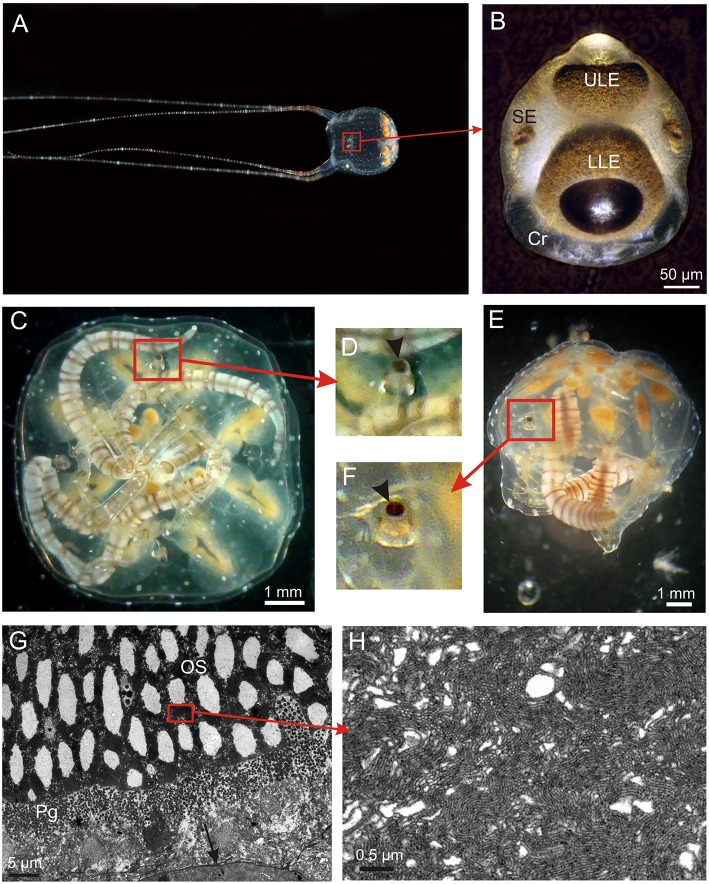
The visual system of Copula sivickisi. (A) An adult male fishing with outstretched tentacles. Framed area indicates location of one of the rhopalia. (B) Close up of a rhopalium showing four of the six eyes. Note the large crystal (Cr) distally. (C) Resting medusae lying upside down but the rhopalia still orient with the upper lens eye pointing straight upwards due to the heavy crystal. (D) Close up of framed area in (C) showing upright rhopalium, arrowhead indicates upper lens eye. (E) Medusa laying on the side still having upright rhopalia. (F) Close up of framed area in (E) showing upright rhopalium, arrowhead indicates upper lens eye. (G) TEM micrograph of photoreceptors in the lower lens eye. The outer segments (OS) are modified cilia, and the photoreceptors also contain screening pigment (Pg). Note apparent holes in the outer segments. (H) Close up of OS showing the cilia projecting densely packed microvilli. LLE, lower lens eye; SE, slit eye; ULE, upper lens eye.